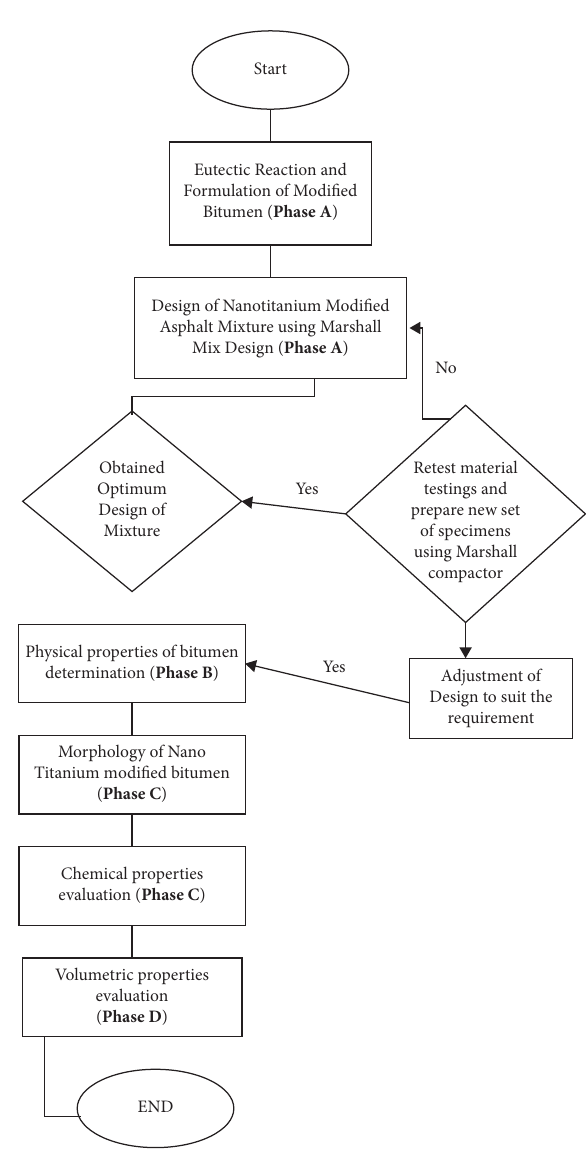
Figure 2: Flowchart of the research